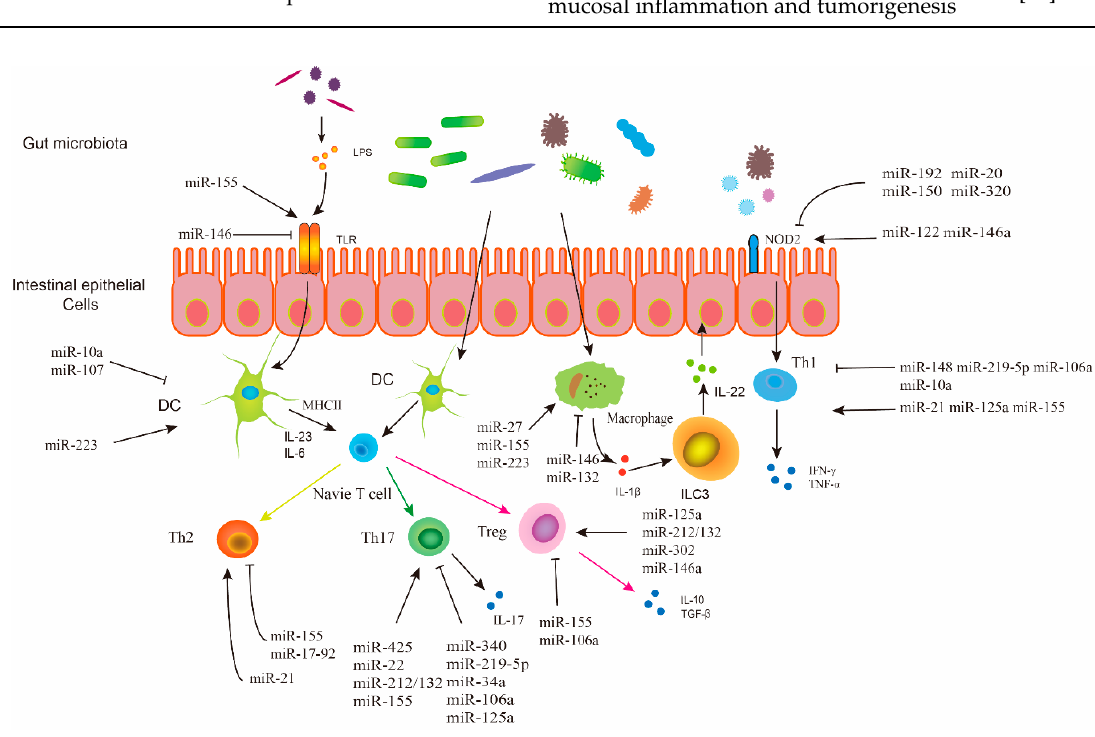
Figure 1. E ff ect of microRNA on the regulation of immune cells in the Figure 1. Effect of microRNA on the regulation of immune cells in the intestine.